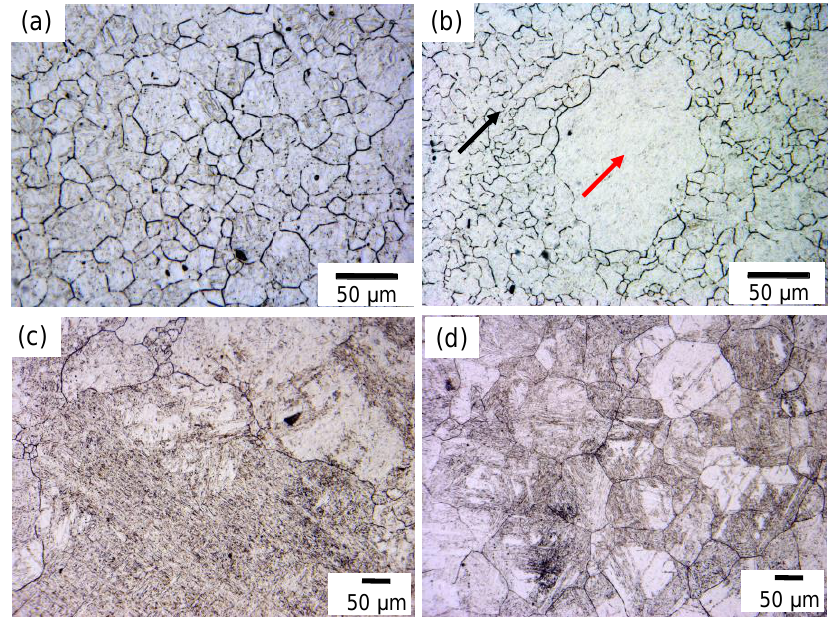
Figure 2. Prior austenite grain structures of the solution-treated (ST) specimens after annealing at ( a ) 1298 K for 1800 s, ( b ) 1323 K for 60 s, ( c ) 1323 K for 1800 s, and ( d ) 1423 K for 1800 s. The red and black arrows in ( b ) to indicate the abnormal coarse and fine matrix grains, respectively.